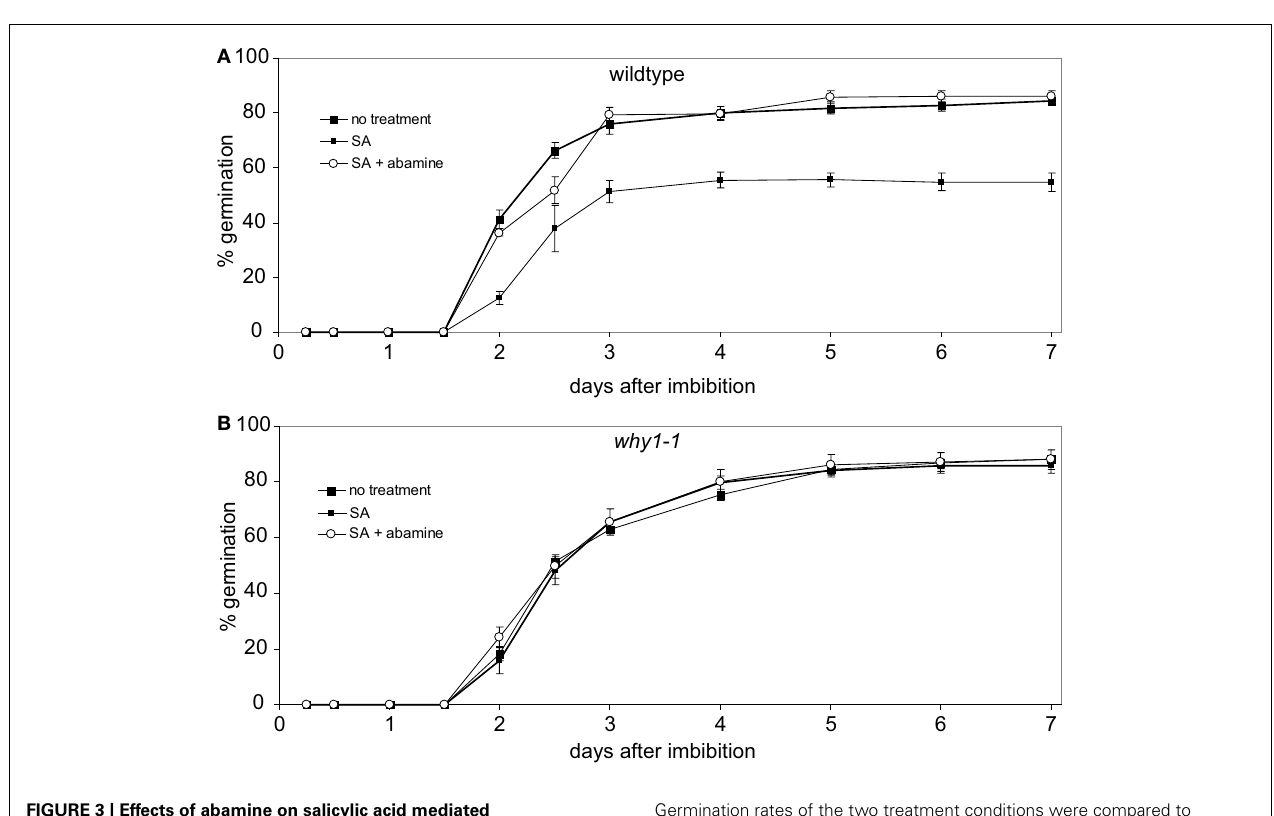
FIGURE 3 | Effects of abamine on salicylic acid mediated repression of germination. Wildtype seeds (A) and seeds of the why1 mutant (B) were grown on agar medium containing 500 µ M salicylic acid (SA) or 500 µ M SA + 50 µ M abamine, respectively.